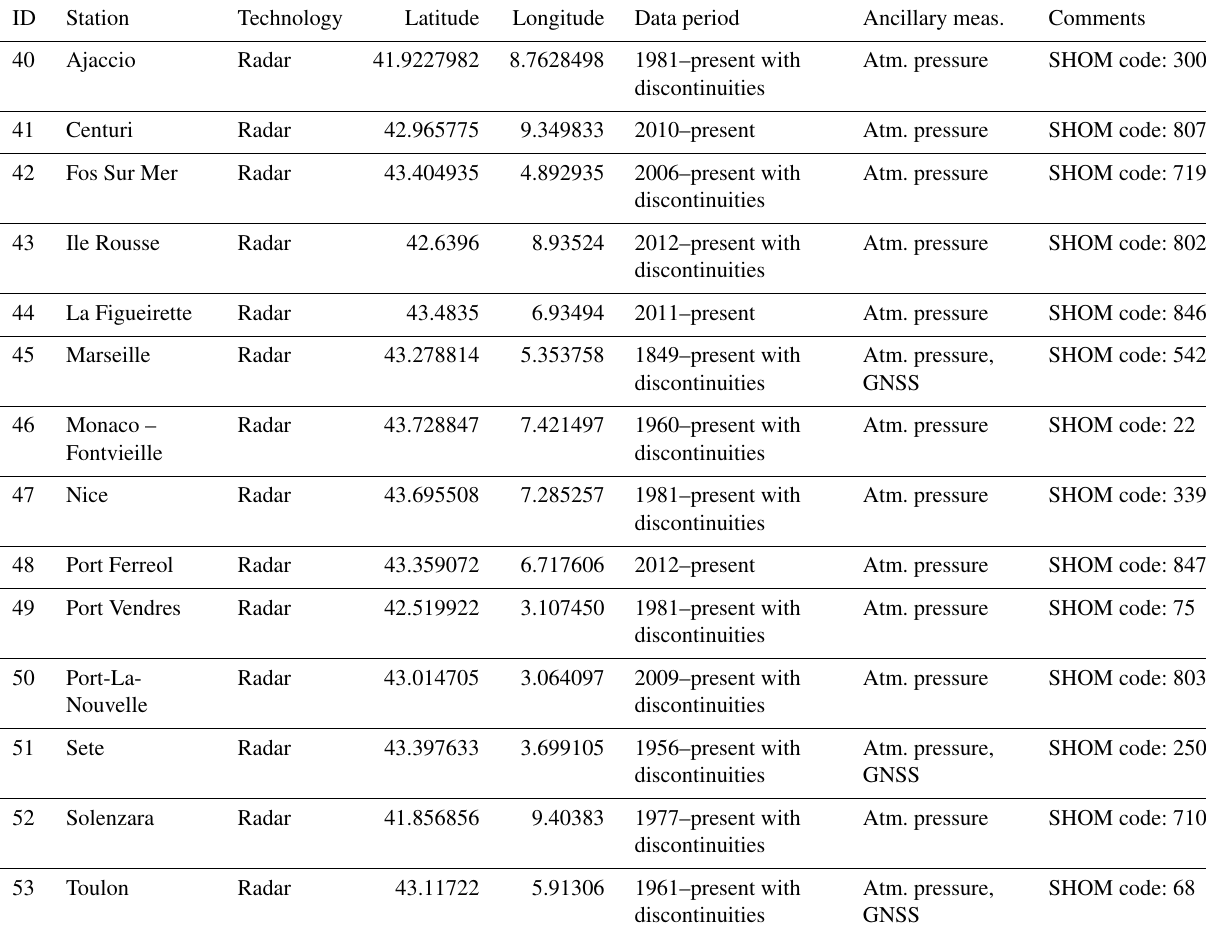
Table A7. Stations operated by SHOM (RONIM network) in France. Data available at https://data.shom.fr/donnees/refmar/nnn, last access: 11 July 2022 (nnn: station code in